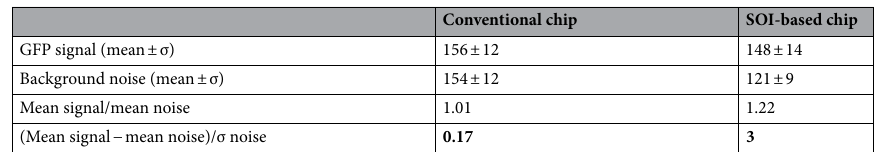
Table 1. Signal and noise parameters from both chip types derived from single-molecule motility TIRF assay. Significant values are in